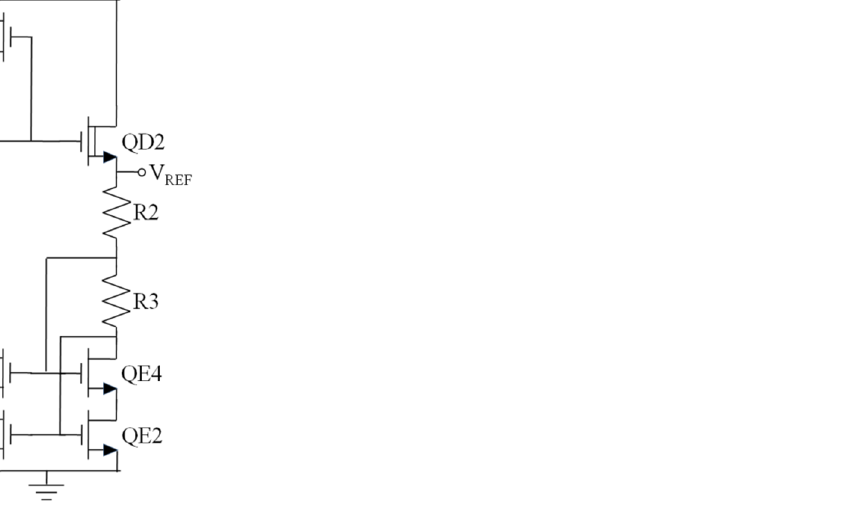
Figure 3. GaN voltage reference based on wide-swing-cascode current mirror [30].